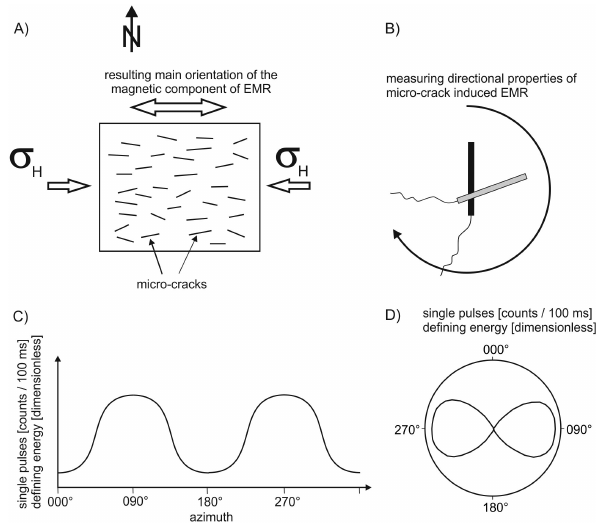
Fig. 2. EMR measuring setup. (A) The main orientation of the mag- netic component of EMR is expected to be parallel to the associated micro-cracks (Obermeyer, 2005b). (B) The directional EMR prop- erties are determined by measuring its magnetic component with the ferrite-core antenna. (C, D) Sketch of determined EMR inten- sities that results from measurements of its magnetic component as a function of direction. In this example the maximum values are measured in E–W